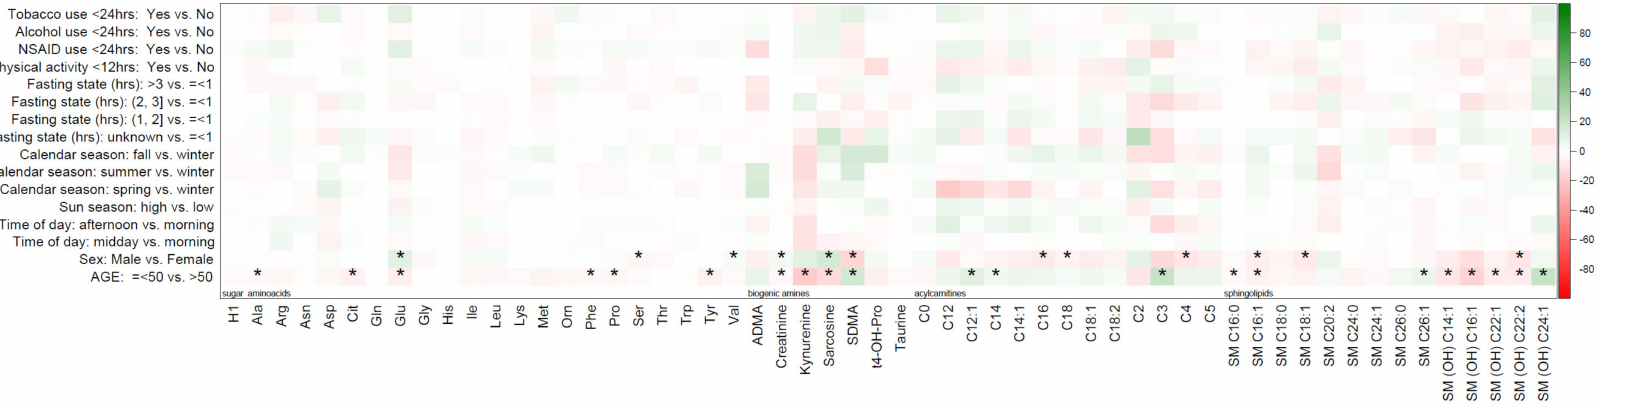
Figure 2. Heatmap of percentage di ff erence in mean metabolite concentrations of acylcarnitines, amino acids and biogenic amines, sphingolipids, and hexoses across categories of pre-blood collection factors in the PRÄVENT cohort ( n = 108). Statistically significant (adjusted for age and sex) findings based on FDR correction indicated with an